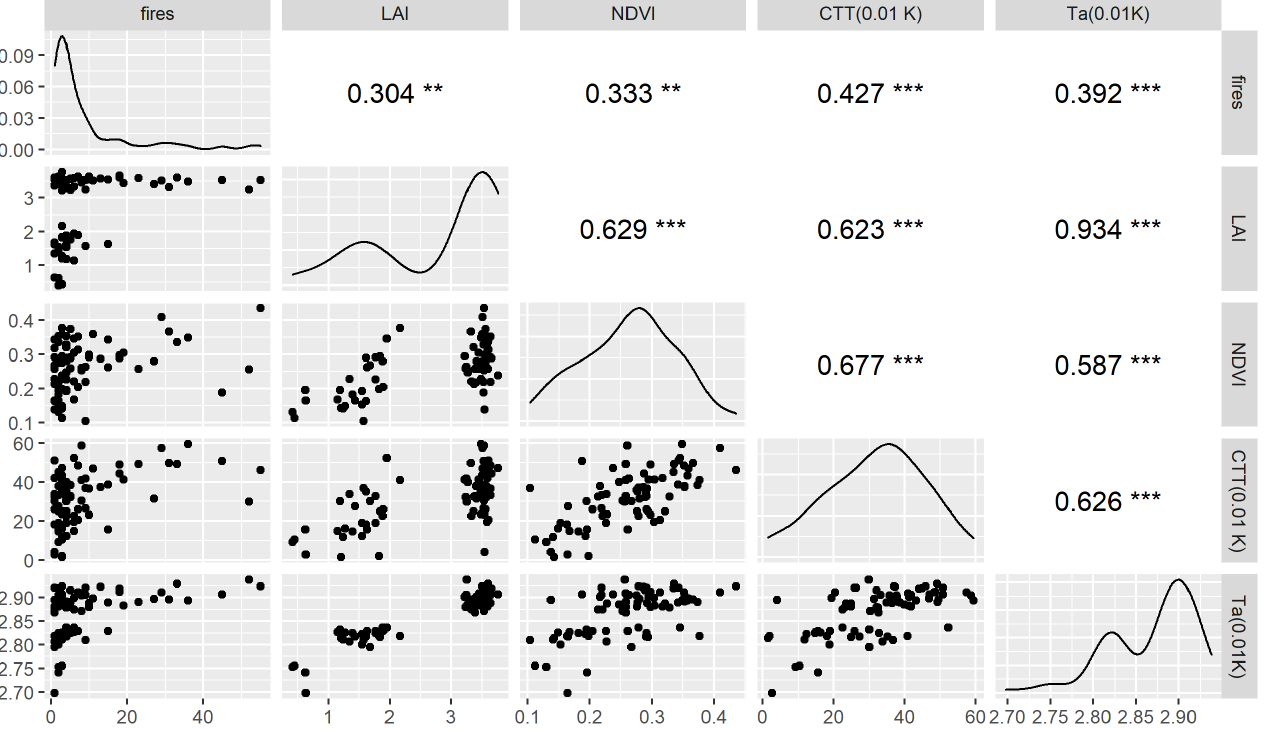
Figure 15. Scatter plot matrix between fire frequency and influential factors (Fires represents fire frequency, Ta is the mean air temperature at 2 m, and other abbreviated names can be found in Table 1, number refers Pearson correlation values, ** means p -values < 0.01, *** means means p -values < 0.001).